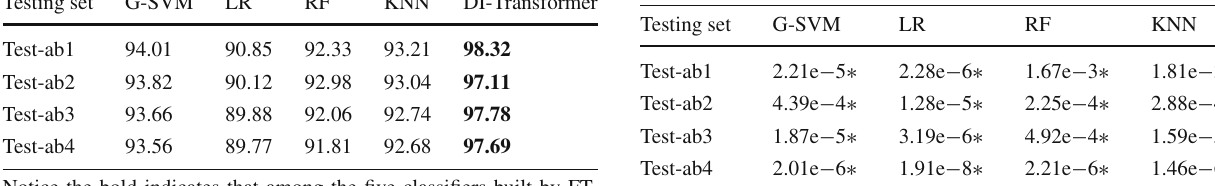
Table 12 p values of Acc between SQI features and FT-IMF all on the four traditional classifiers Testing set